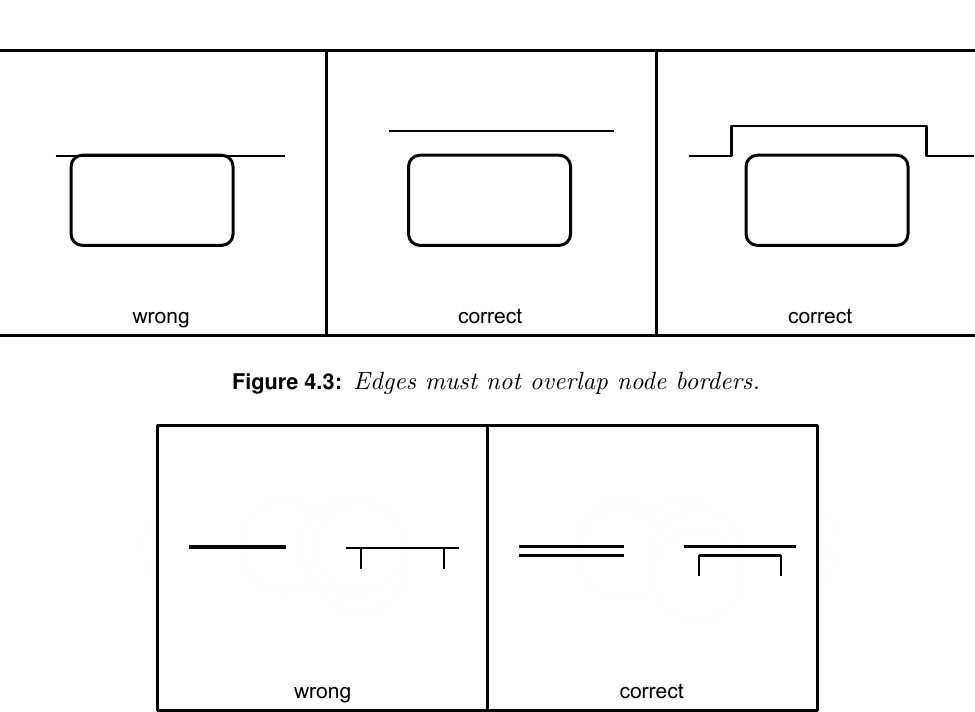
Figure 4.4: Edges must not overlap.